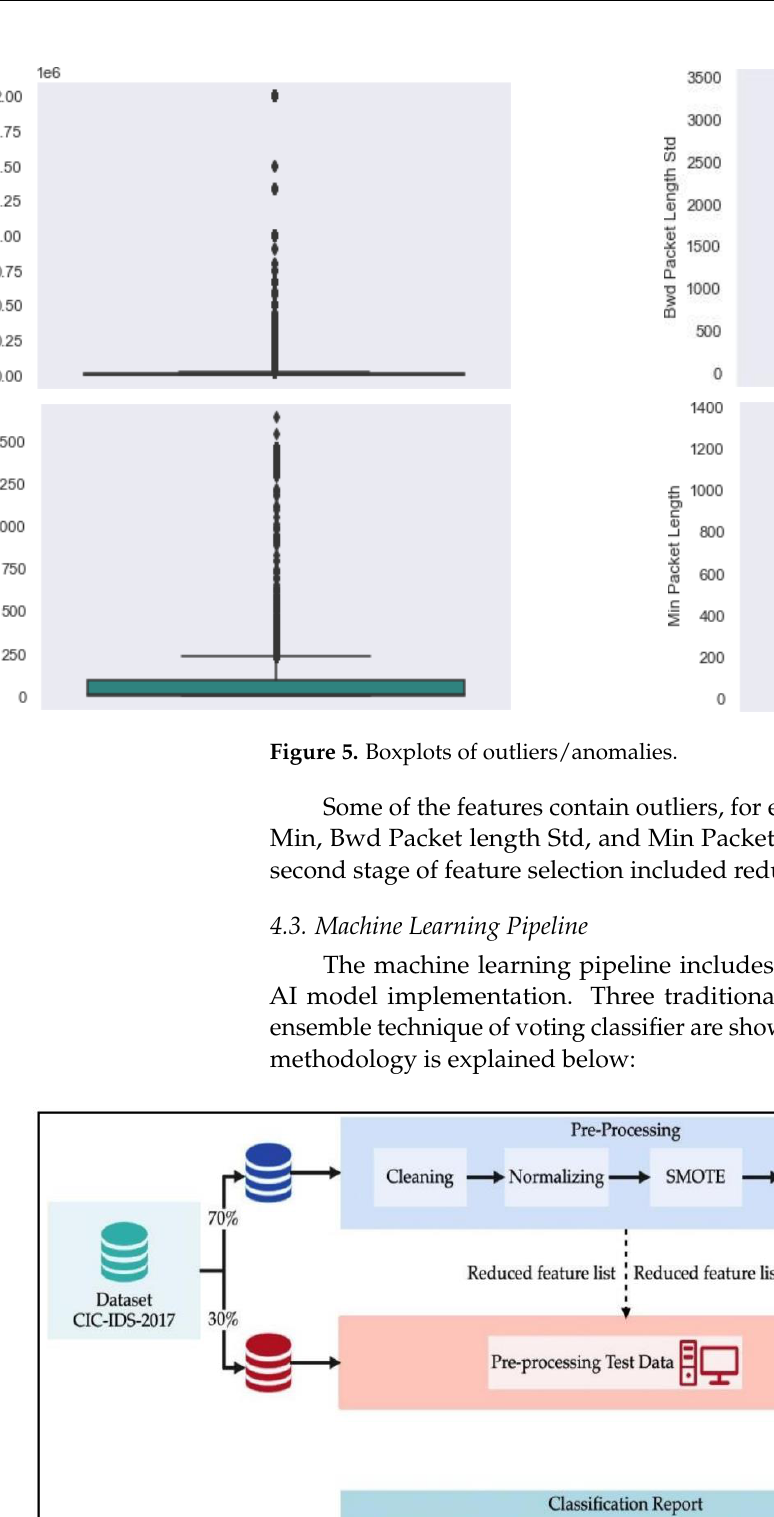
10 of 25 Figure 4. Correlation heatmap of features for the second stage. Finding outliers: A data point that is abnormally dispersed compared to other points is considered an outlier. Basically, it refers to data that differ from the other values in the